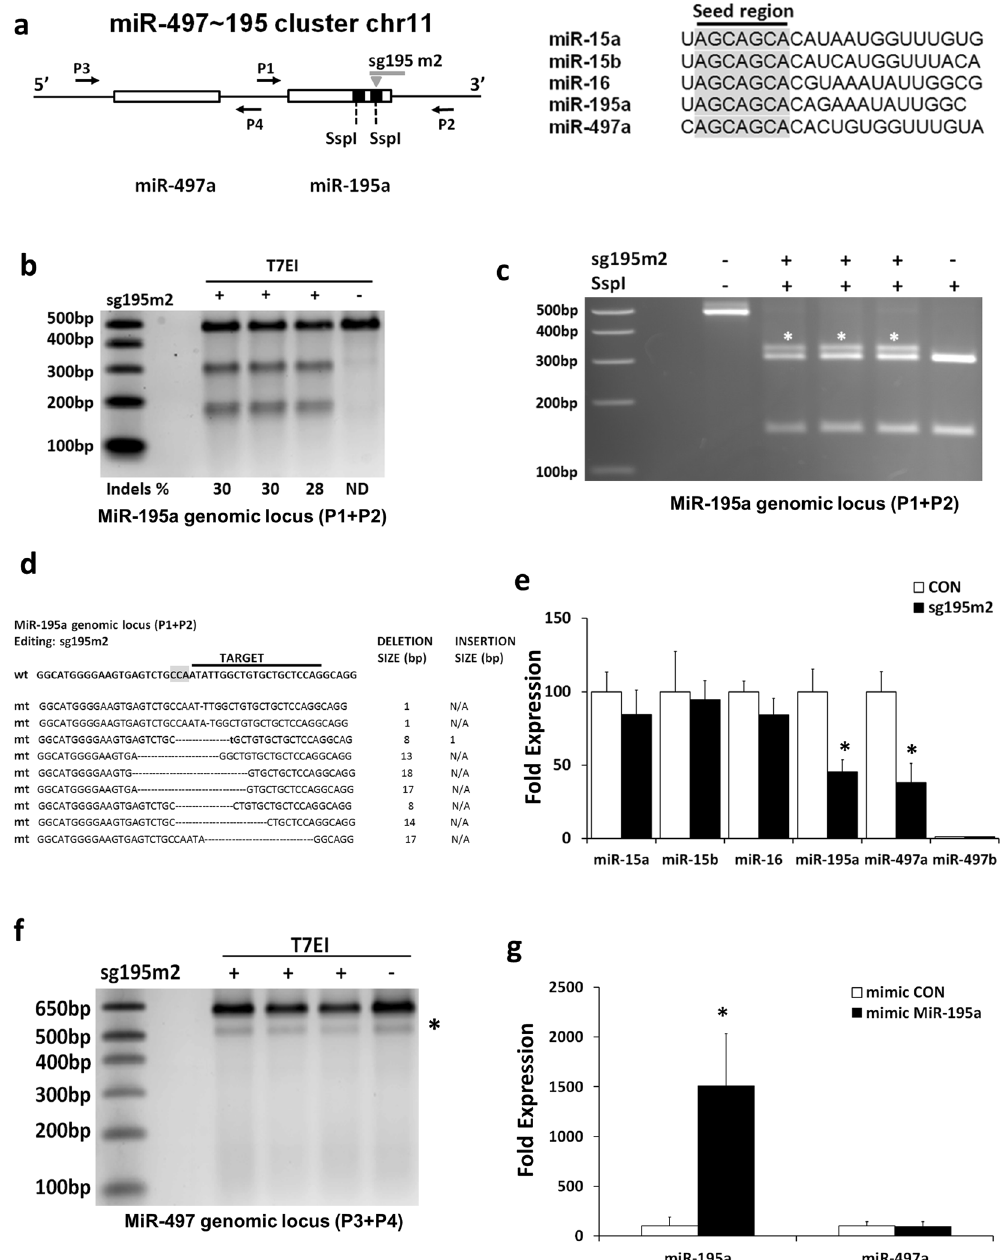
Figure 1. Gene editing of the miR-195a locus. ( a ) The genomic locus of the miR-497~195 cluster. MiR-195a forms a cluster with miR-497a and is transcribed as a single primary transcript. MiR-497b is encoded by the antisense strand and displays high homology with miR-497a but does not harbour the same seed sequence. Right panel, miR-15 family members share a common seed region (highlighted in grey) and display high sequence homology. ( b ) T7EI assay for the miR-195a locus. Three independent experiments were performed. ND: non detectable ( c ) The sg195m2 targets the miR-195a genomic locus and disrupts an SspI restriction site. Asterisks ( * ) indicate differential digestion products. ( d ) Sanger sequencing of the edited miR-195a genomic locus revealed the presence of random indels, mainly deletions, represented as dashes. The PAM sequence is highlighted in grey. Insertions are shown in bold small case fonts. N/A: Not Applicable. ( e ) Gene editing of the miR-195a locus resulted in the down-regulation of both miR-195a and miR-497a without affecting the expression of other members of the miR-15 family as assessed by qPCR. MiR-497b that is also encoded in the miR-497~195 cluster is not expressed in VSMCs. U6 was used as a normalization control. n = 3, * p < 0.05 Student’s t-test with Bonferroni post hoc test ( f ) T7EI assay for miR-497a genomic locus did not reveal any editing in the genomic locus of miR-497, * nonspecific T7EI digestion product. ( g ) QPCR quantification of mature miR-195a and miR-497a expression, following overexpression of miR-195a using miRNA mimics. U6 was used as a normalization control. n = 3, * p < 0.05 Student’s t